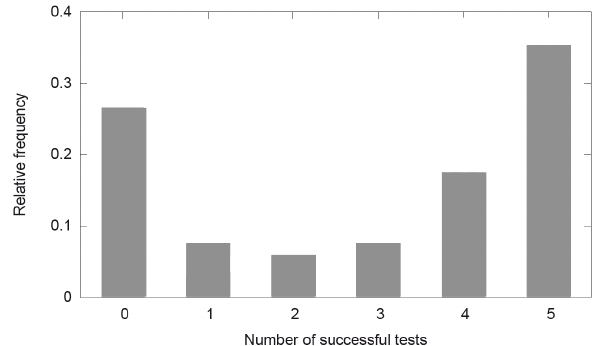
Figure 3. Histogram of successful goodness-of-fit tests. The relative frequency of the amount of experiments that surpass a certain number of tests (up to five) is calculated with respect to the total number of experiments initially implemented.